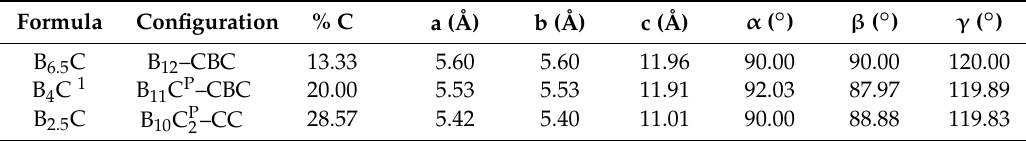
Table 1. Lattice parameters of boron carbides.